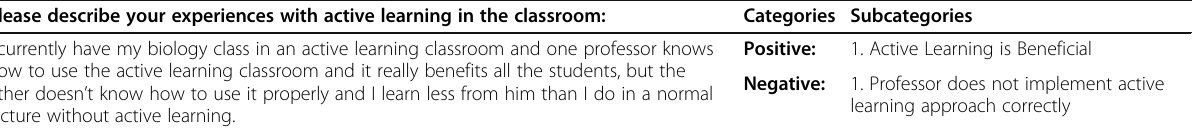
Table 3 Student Response Coding Template/Example Please describe your experiences with active learning in the classroom: Categories